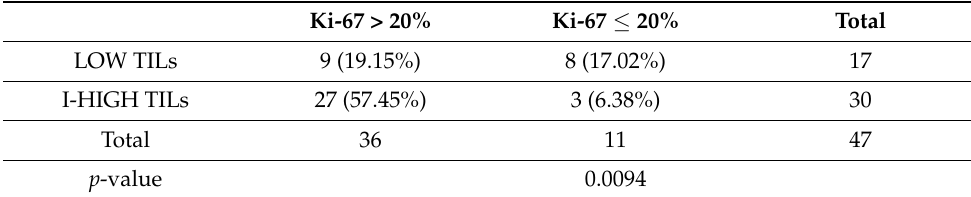
Table 4. Relation between TILs and proliferative index (Ki-67).